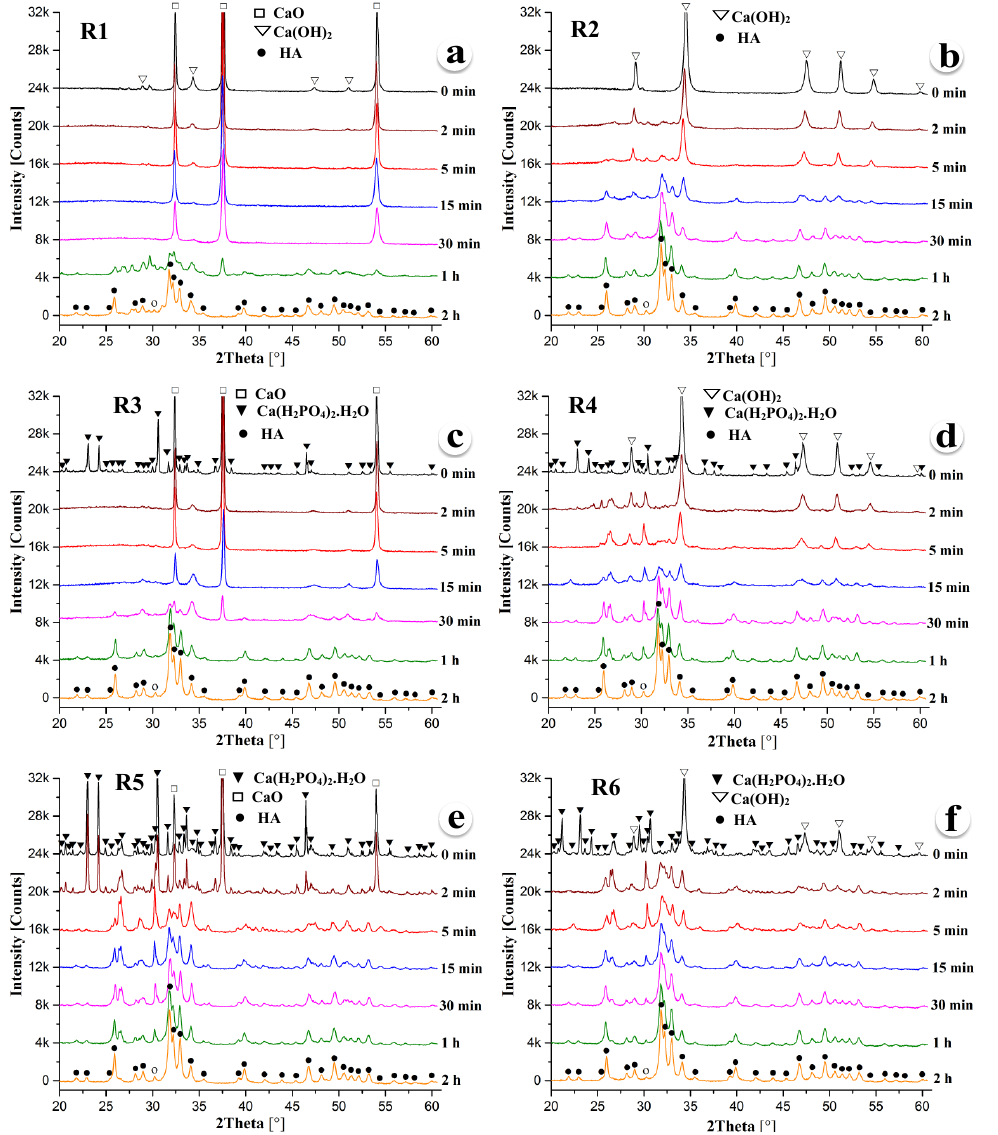
Figure 1. X-ray diffraction (XRD) patterns of the powder mixtures ( a ) R1, ( b ) R2, ( c ) R3, ( d ) R4, ( e ) R5, and ( f ) R6 after ball milling for 0 min, 2 min, 5 min, 15 min, 30 min, 1 h, and 2 h.